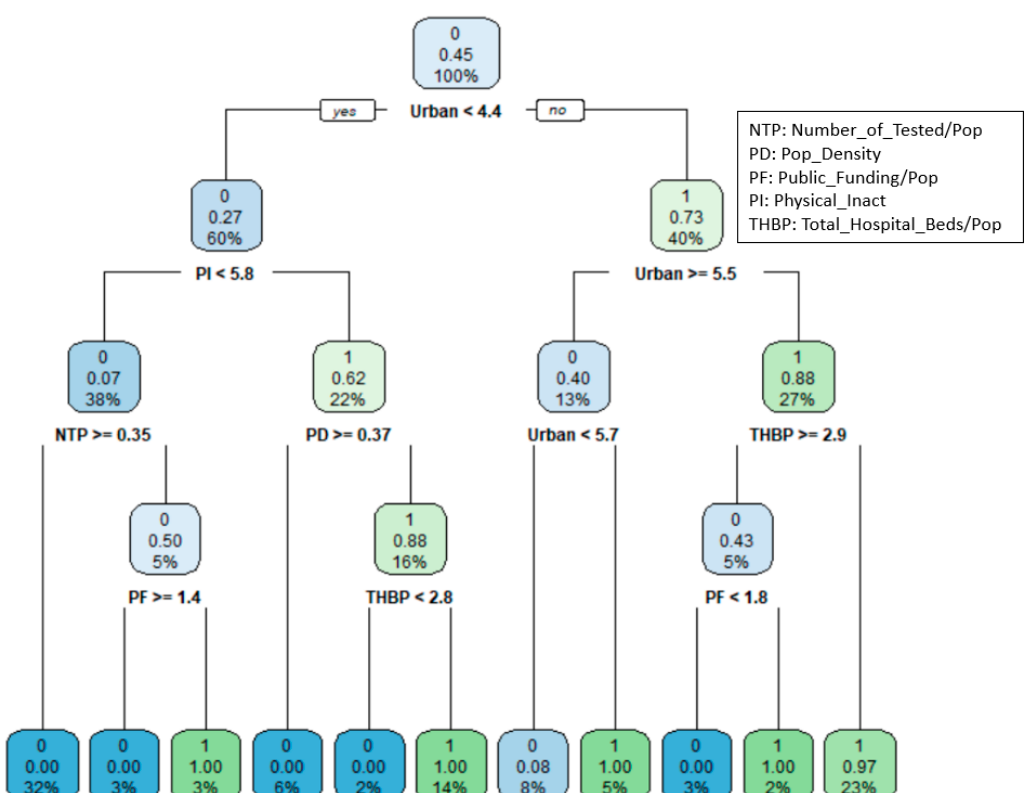
Figure 3. CART Results for States COVID-19 Responsive Performance.